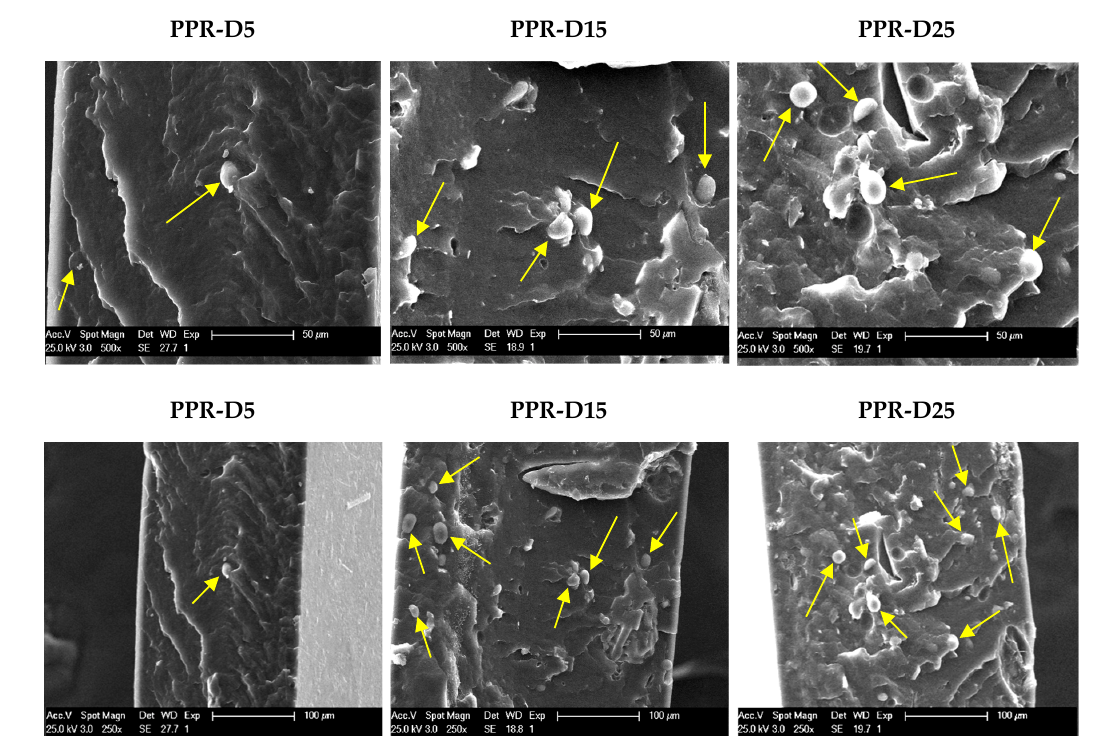
Figure 1. SEM images at two magnifications for the indicated samples. Some of the DSF particles are marked by yellow arrows.